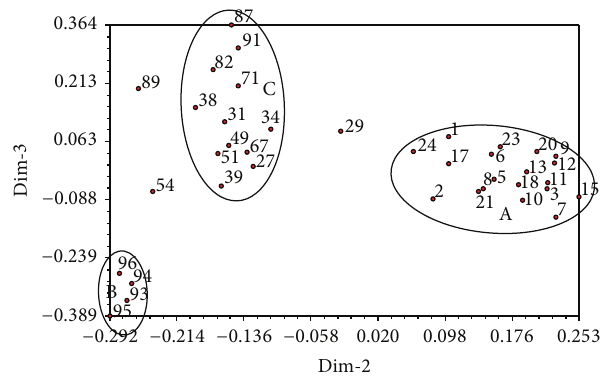
Figure 8: Principal components analysis of 38 S. scitamineum isolates from ROC22 based on the combined ISSR + SP-SRAP